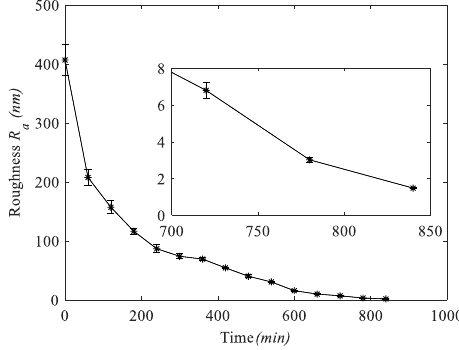
Micromachines 2020 , 11 , x FOR PEER REVIEW Figure 9. The change of surface roughness. Figure 9. The change of surface roughness.